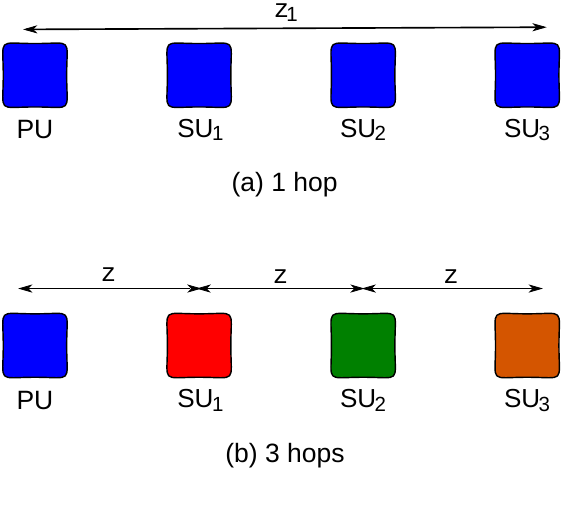
Figure 9. Static X-NETAD application testbed: ( a ) Scenario 1 , all Secondary Users (SUs) are located in the transmission range of the PU; ( b ) Scenario 2 , each SU is at the edge of the transmission range of previous nodes.